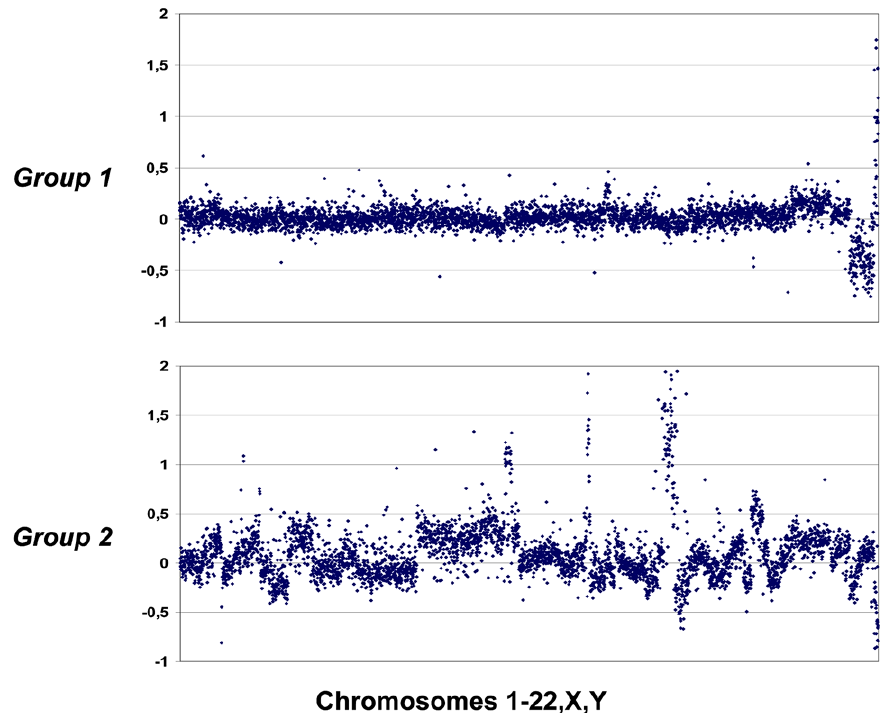
Fig. 2. Typical examples of an aCGH profile of each group. Upper panel represents a tumor with a silent profile and wild-type TP53 , showing just a few aberrations. Lower panel shows a typical profile of a tumor of group 2 showing many aberrations, e.g. with gains at 3q, chromosome 8, 11q13, 17q, chromosome 20, and losses at 3p, 11q23 and 13q.